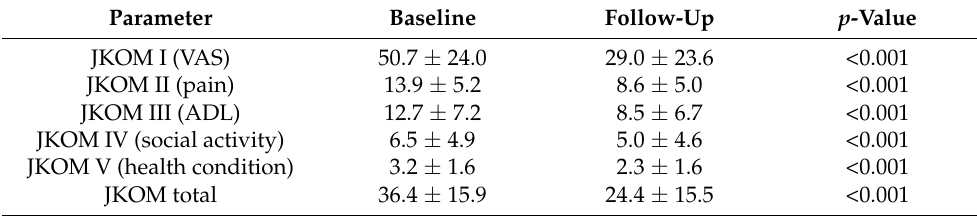
Table 2. Clinical outcomes after treatment with plasma rich in growth